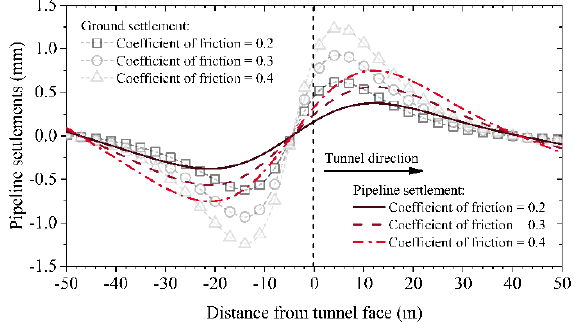
Figure 14. Longitudinal profiles of pipeline’s deformation with different frictional forces.